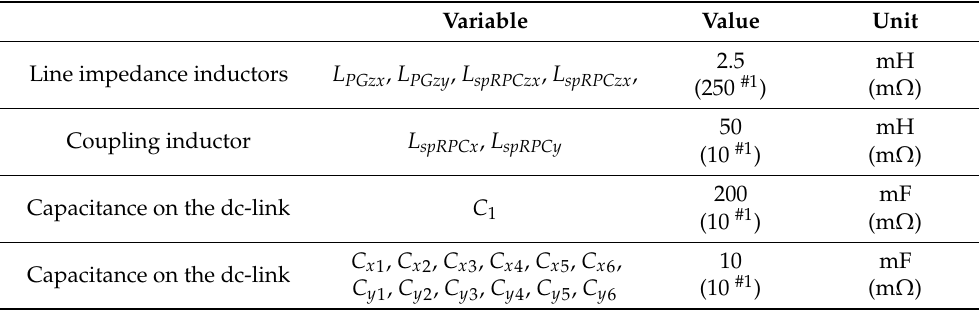
Table 2. Main parameters of the electric components used on the sp-RPC topology based on